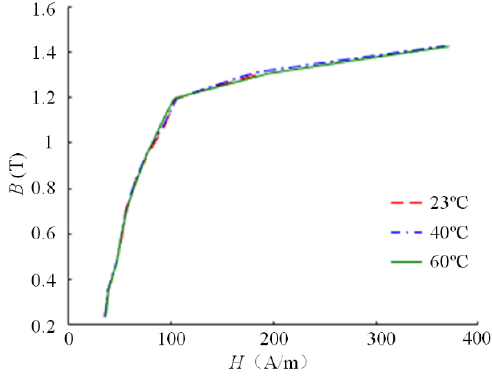
Figure 7. B–H curves under different temperatures.